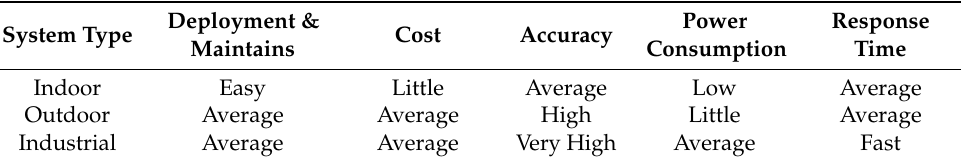
Table 1. Pollution monitoring systems and related